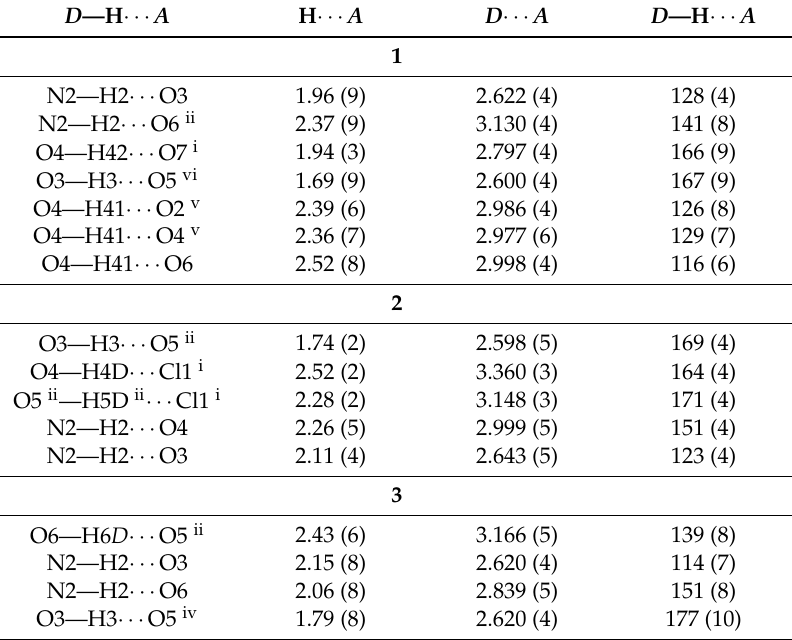
Table 3. Hydrogen-bond geometry (Å, ˝ ) in complexes 1 – 3 a .